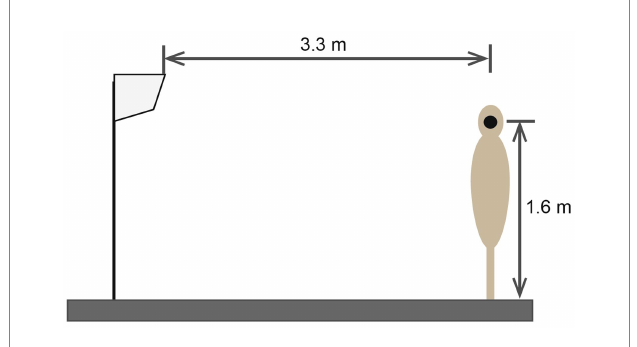
FIGURE 1 Installation of air conditioner units in an anechoic room. The binaural microphone was placed at the ear position on the